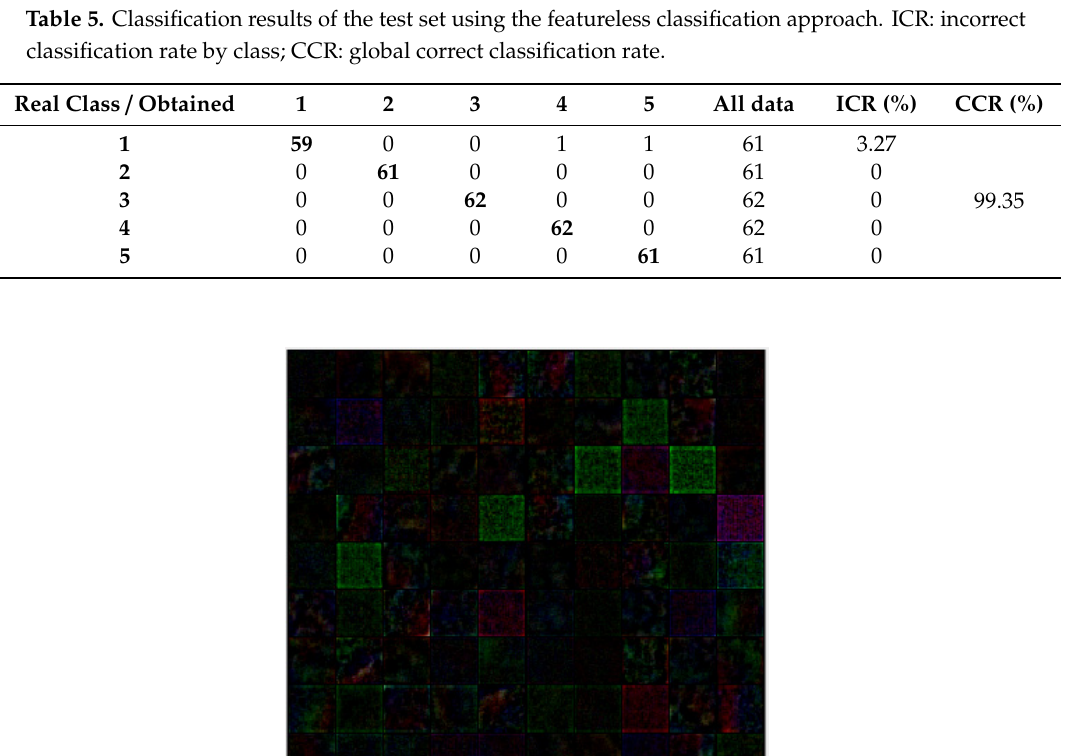
96.49 Table 7. Performance criteria related to the confusion matrix using the featureless approach. Class